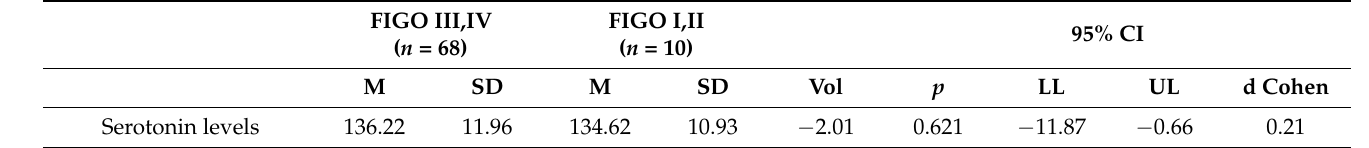
Table 7. The preoperative levels of serotonin in the group with ovarian cancer—III–IV stage according to FIGO and the group with ovarian cancer—I–II stage according to FIGO. FIGO